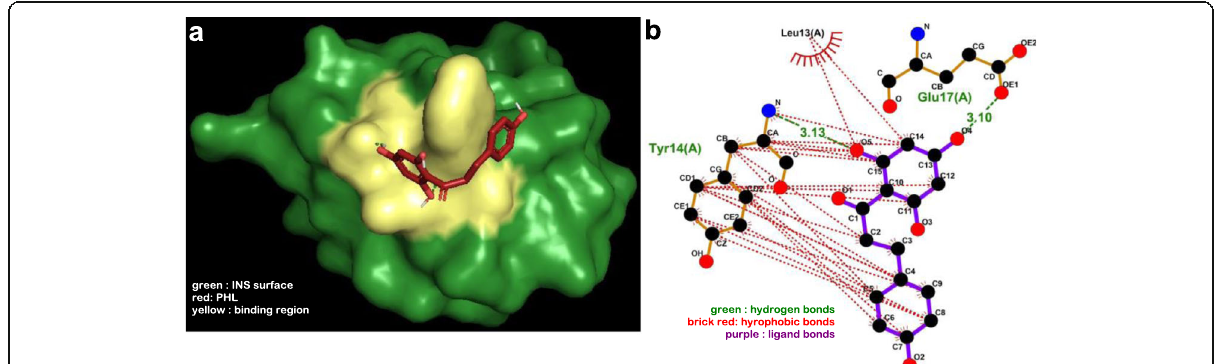
Fig. 11 PHL and INS interaction by molecular docking. a the surface of INS. b LigPlot